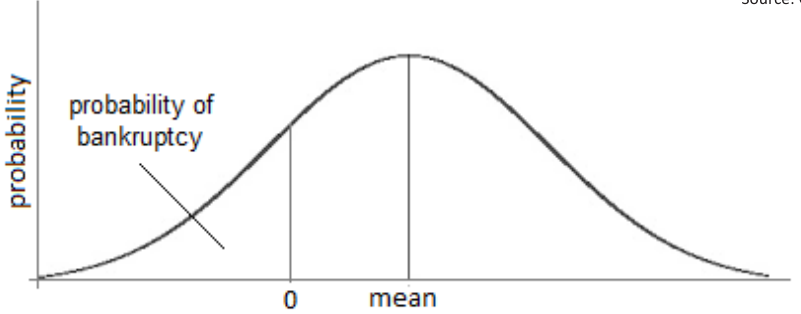
Figure 1. Monte Carlo simulation result of investing in